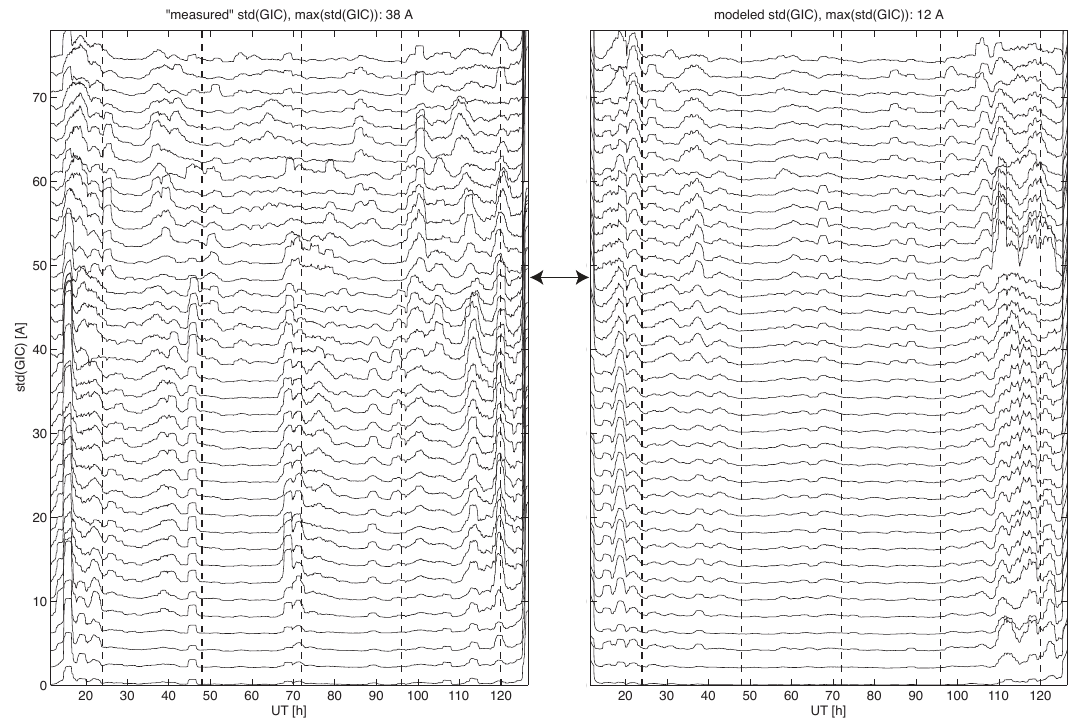
Fig. 7. Standard deviation of GIC data in Fig. 6. The standard deviation was computed for moving windows having length of 120min.